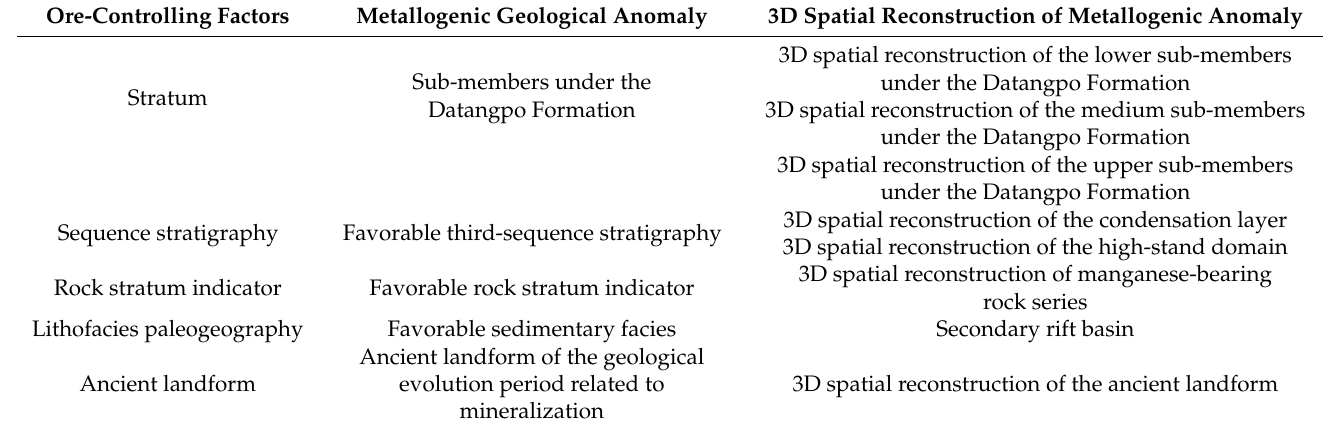
Table 6. 3D spatial reconstruction of the Minle manganese